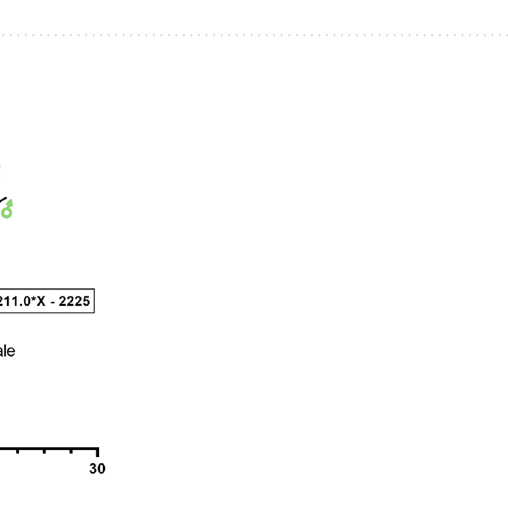
Figure 8. Linear regression performed for potassium concentration in male, female mice with weight, slope for females (166.3 ± 91.38), and male (211.1 ± 92.2) regression lines were not significantly different.